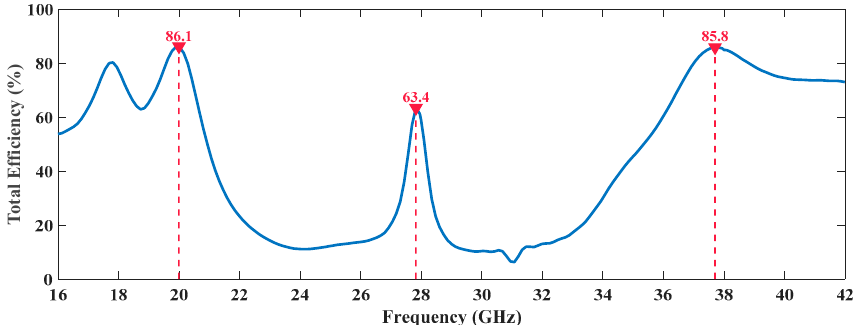
Figure 10. E ffi ciency Variation Over Frequency of the Tri-Band Antenna. Figure 10. Efficiency Variation Over Frequency of the Tri-Band Antenna. Figure 10. Efficiency Variation Over Frequency of the Tri-Band Antenna.